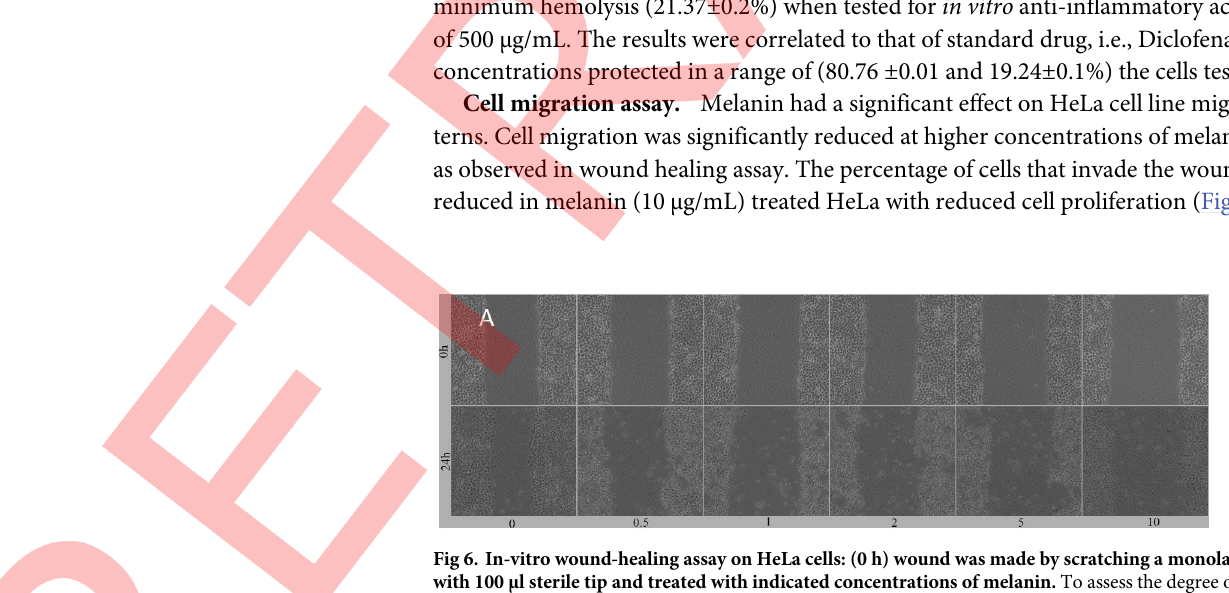
value ( μ g/mL) 50